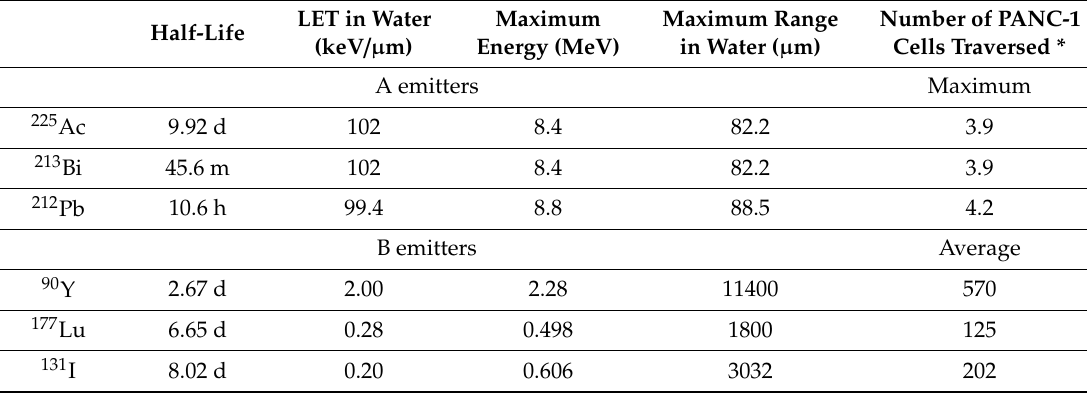
Table 1. Physical characteristics of α - and β -emitting radionuclides used for RIT of